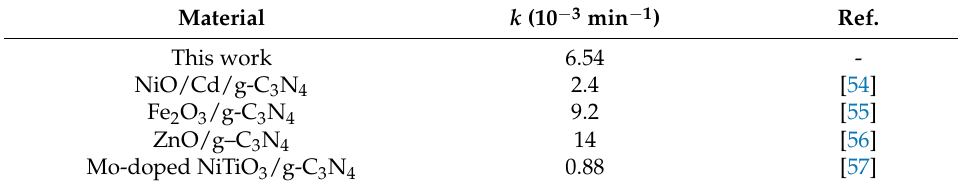
Table 3. Comparison with other photocatalysts for the degradation of MB